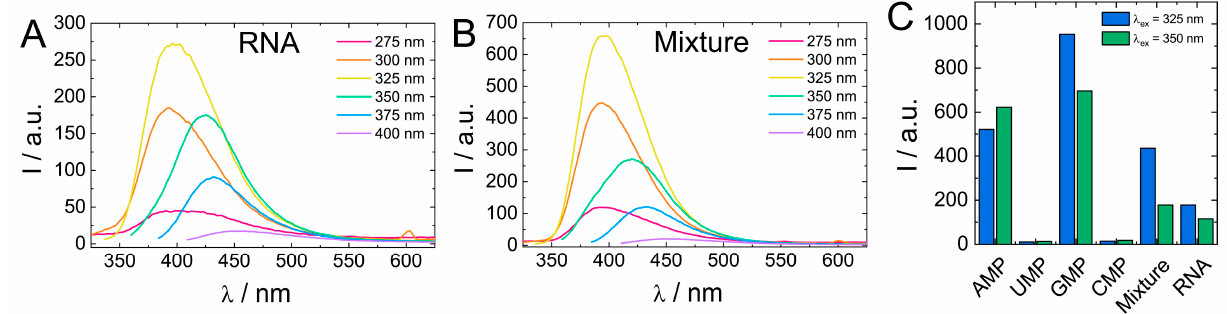
Figure 9. ( A , B ). Comparison of fluorescence spectra of 0.01% ( w / v ) solutions of biodots prepared from RNA ( A ) and a 1:1:1:1 mixture of AMP:UMP:GMP:CMP ( B ). Concentration of RNA and the total concentration of nucleotides during HT synthesis were the same (1.0%). ( C ). Comparison of fluorescence intensities of biodots prepared from individual nucleotides, their mixture, and RNA at λ ex = 325 nm and λ ex = 350